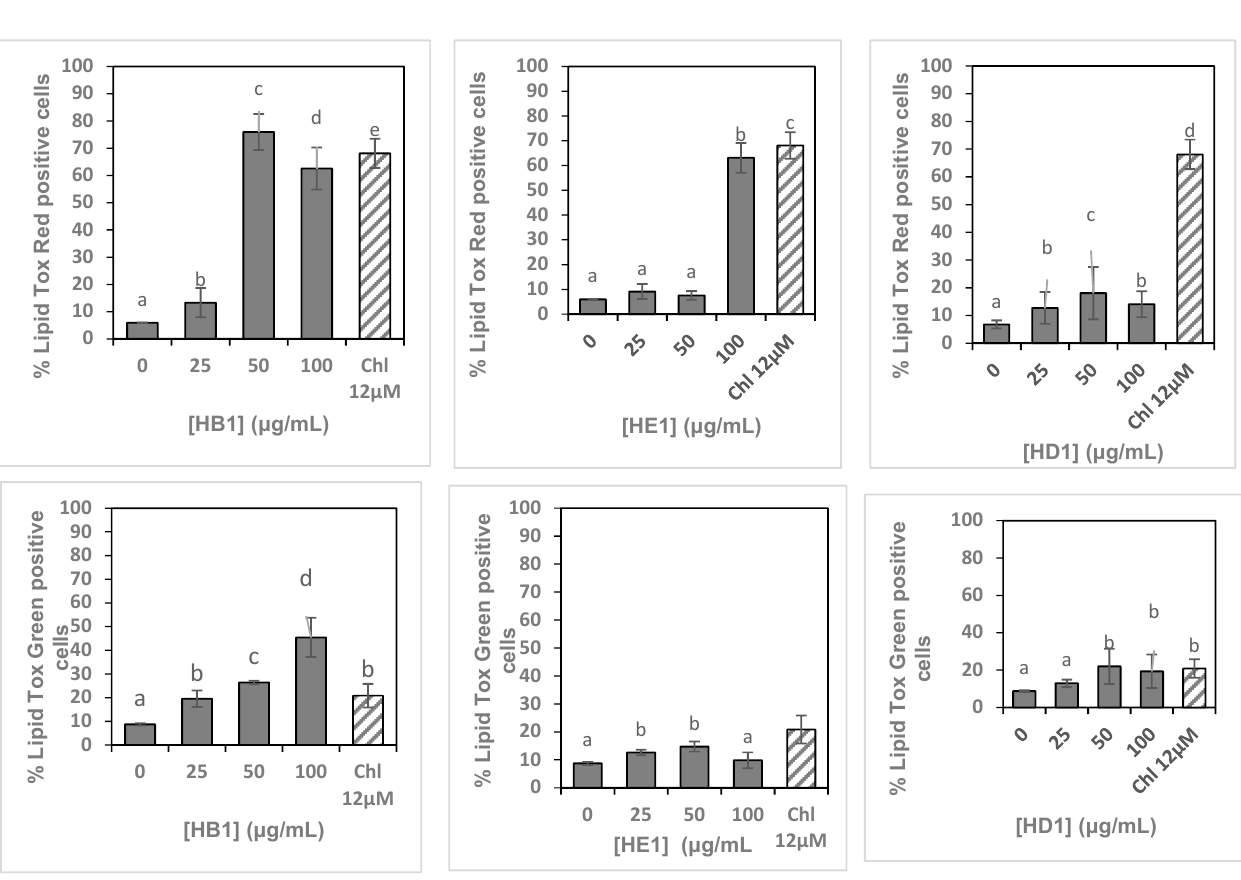
Figure 8. Neutral lipid (LipidTox Red) and phospholipid (LipidTox Green) accumulation in C3A cells treated with indicated extracts and chloroquine (positive control) for 48 h. HB—Blanched; HE—Ethanol and HD—Aqueous extracts; Chl.–Chloroquine; Data is expressed as a percentage of cells staining positive for each treatment. Mean separation by SD ( p < 0.05). Set of bars with different alphabets are significantly different. The corresponding images of the C3A cells treated with H. arborescence leaf extracts are indicated in Figure 9.